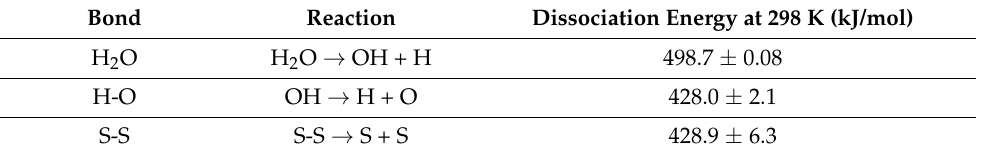
Table 1. Dissociation energy for the bonds selected